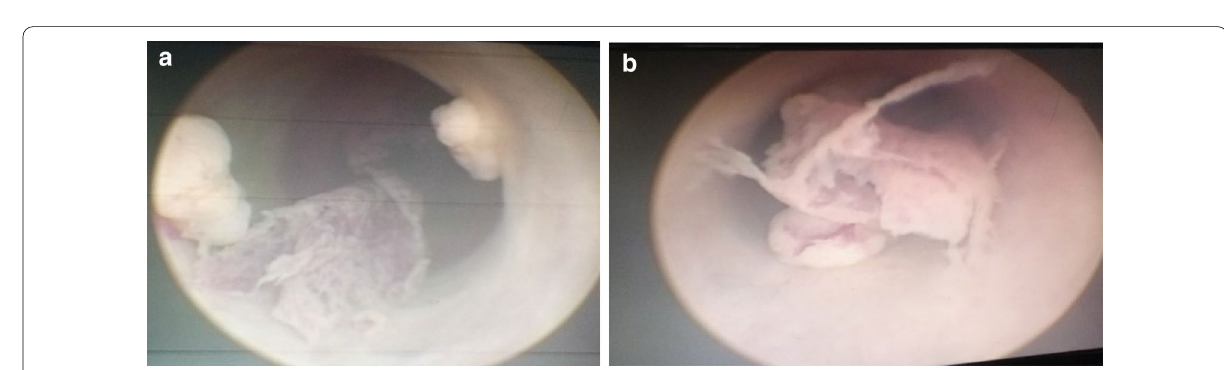
Fig. 2 a Multifocal masses within the urethral lumen b Mass occluding the urethral lumen at the bulb